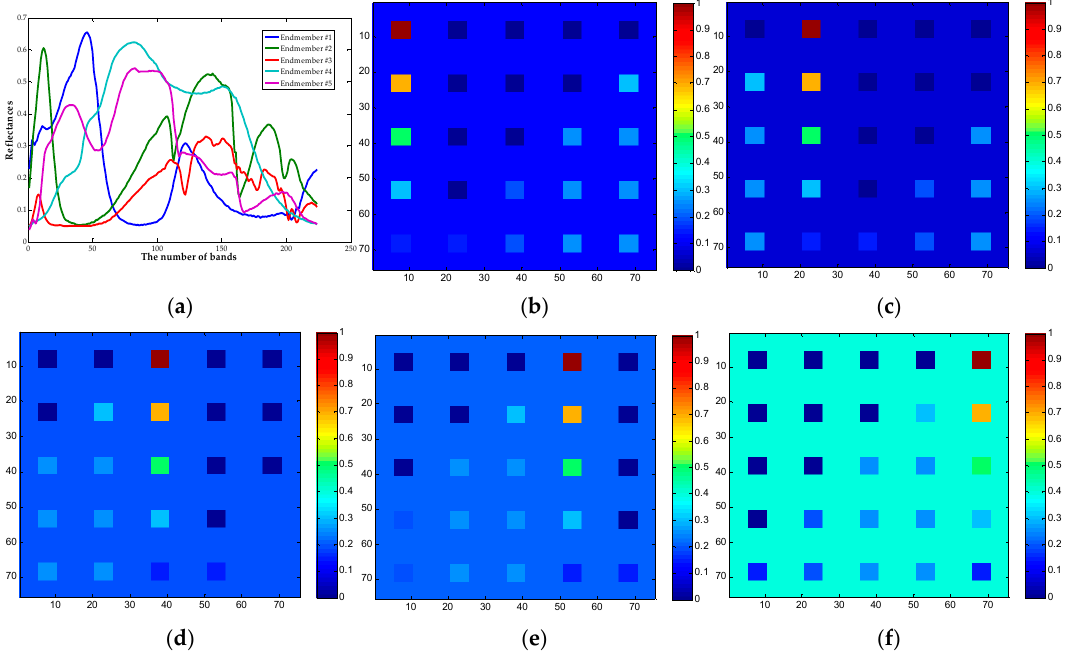
Figure 3. Simulated Data Cube 1 (DC-1). ( a ) The five spectra. ( b ) Abundance map of #1. ( c ) Abundance map of #2. ( d ) Abundance map of #3. ( e ) Abundance map of #4. ( f ) Abundance map of #5.